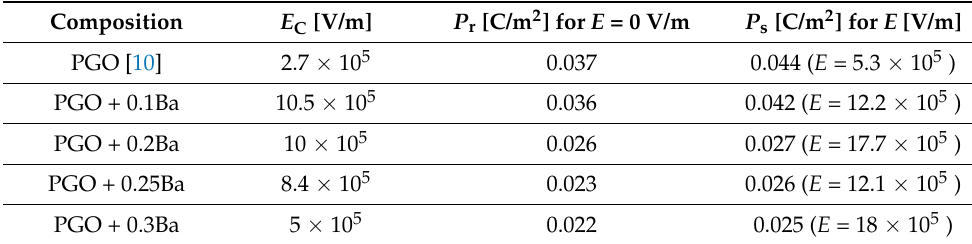
Table 2. A comparison of the values of coercive field E c , remnant polarization P r , and spontaneous polarization P s for the PGO + xBa (x = 0.1, 0.2, 0.25, and 0.3) collected at RT.